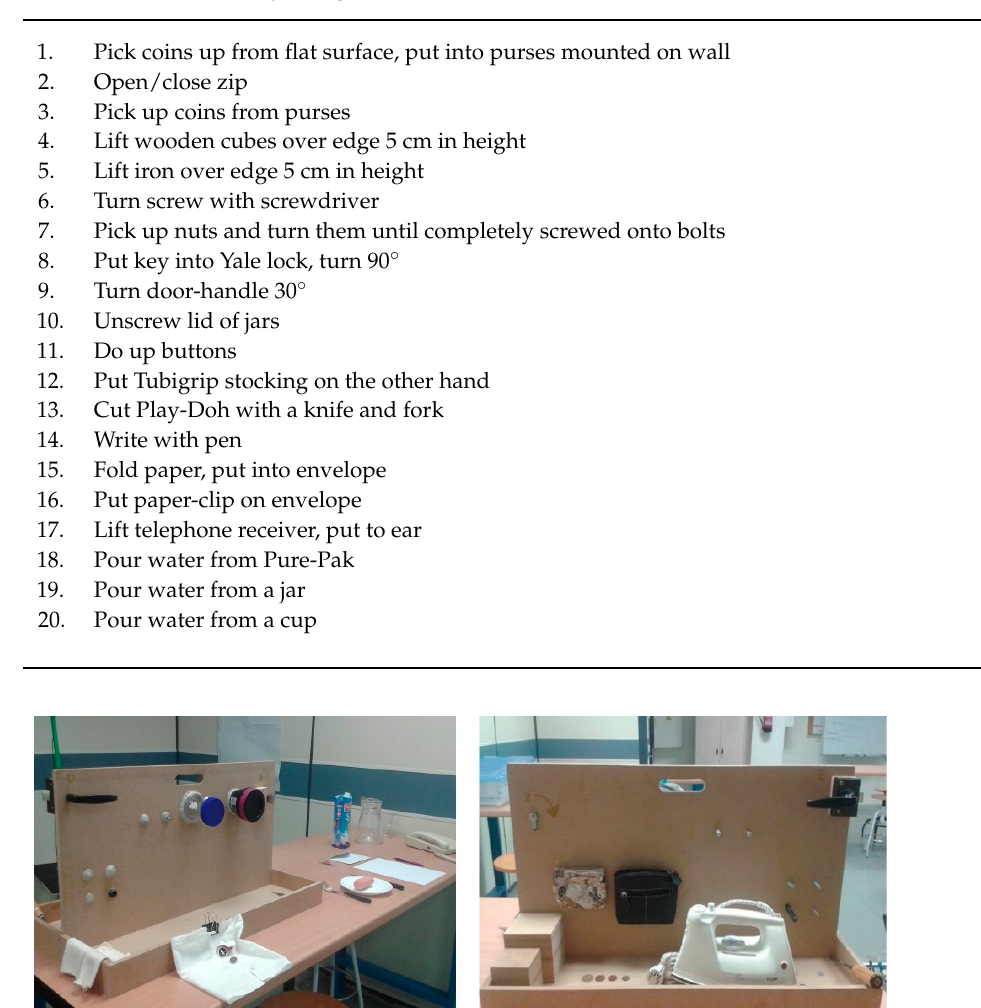
Table 1. Activities of daily living considered in the Sollerman hand function test.